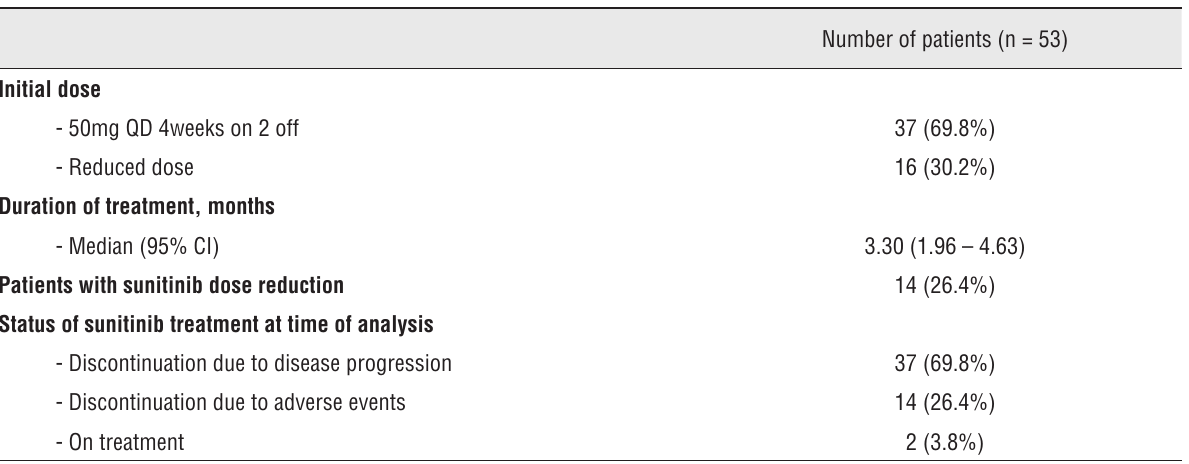
Table 2 - Sunitinib treatment patters.